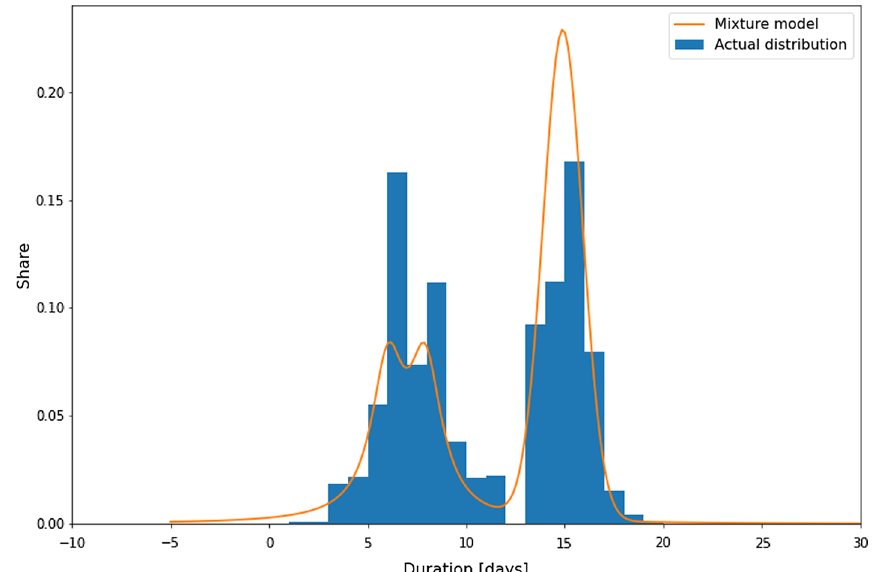
Fig. 8 Predicted mixture model for transport time from Shanghai to the United States. Source : Own